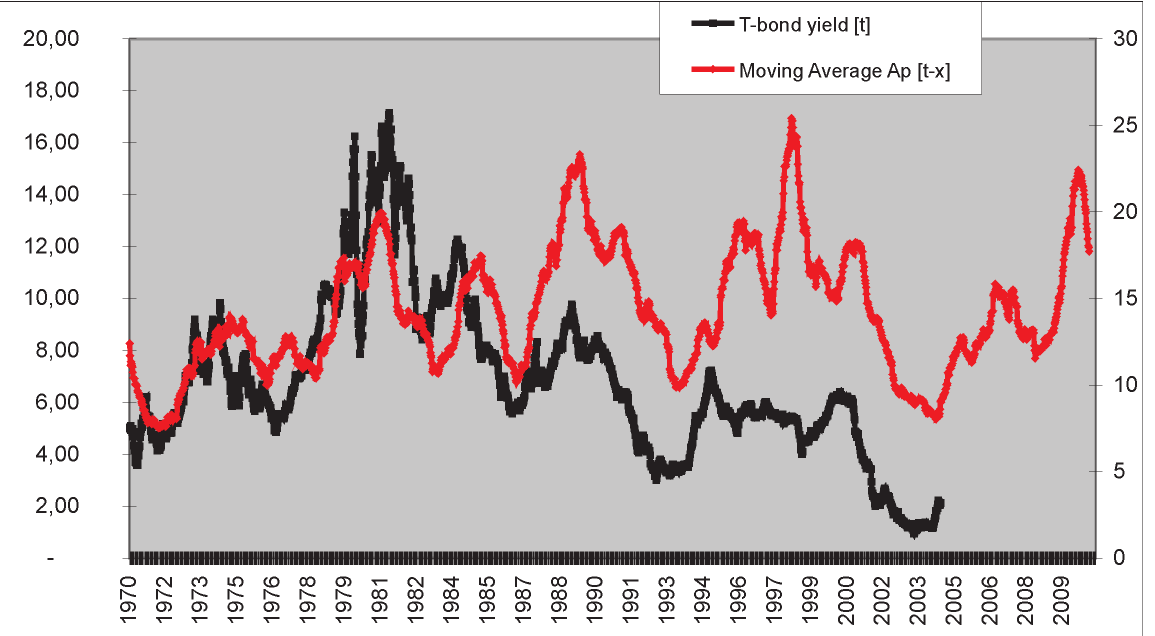
Fig 4. Weekly time series: US T-bond average year yield and moving average geomagnetic activity index Ap [t-x] - with lag